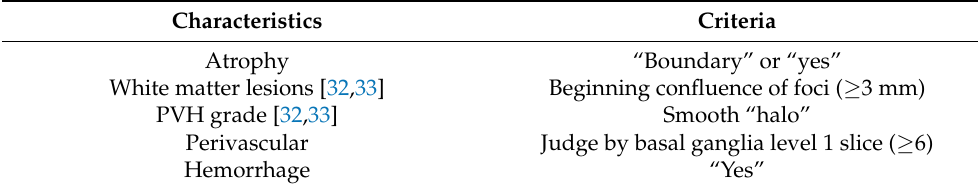
Table 1. Diagnosis criteria for brain disorders using